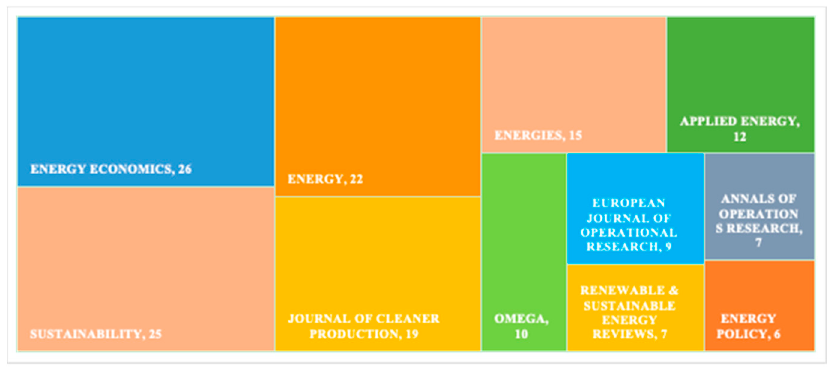
Figure 1. Journal distribution and number of publications.